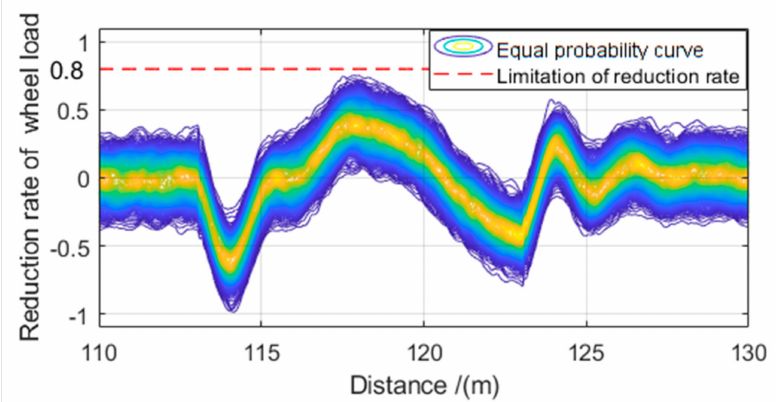
Figure 10. Safety index at different amplitudes.